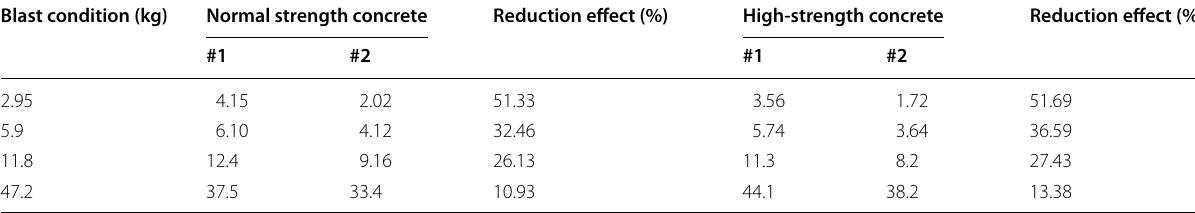
Table 8 Results of parametric study on explosion load Blast condition (kg) Normal strength